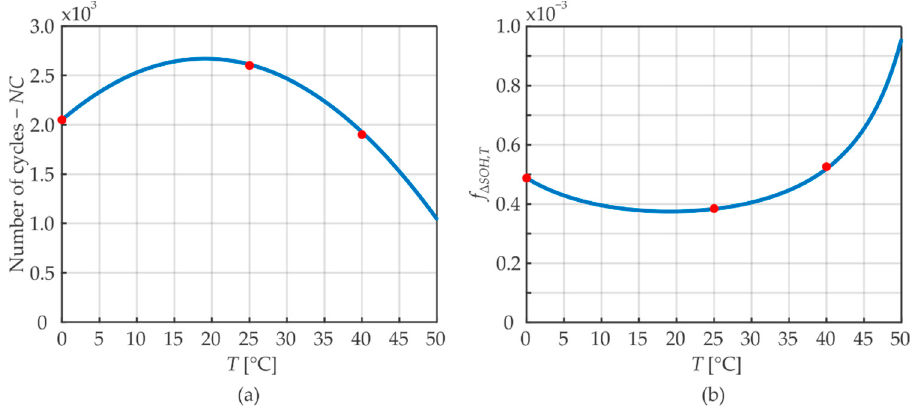
Figure 4. Influence of the temperature: ( a ) number of cycles and ( b ) f Δ SOH,T .